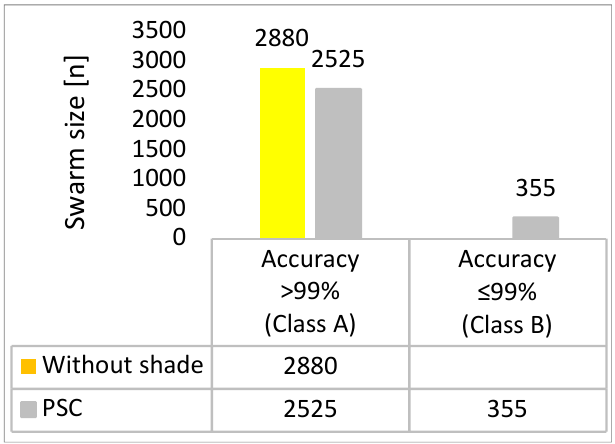
Figure 7. Accuracy and classification of simulation results independently of the